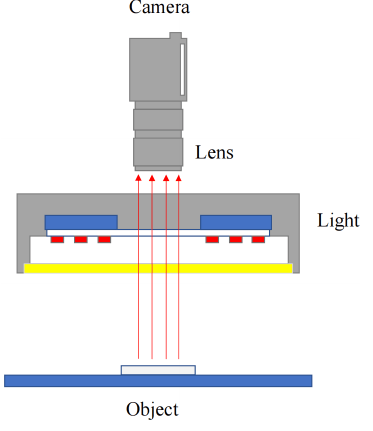
Figure 3. White ring light source.